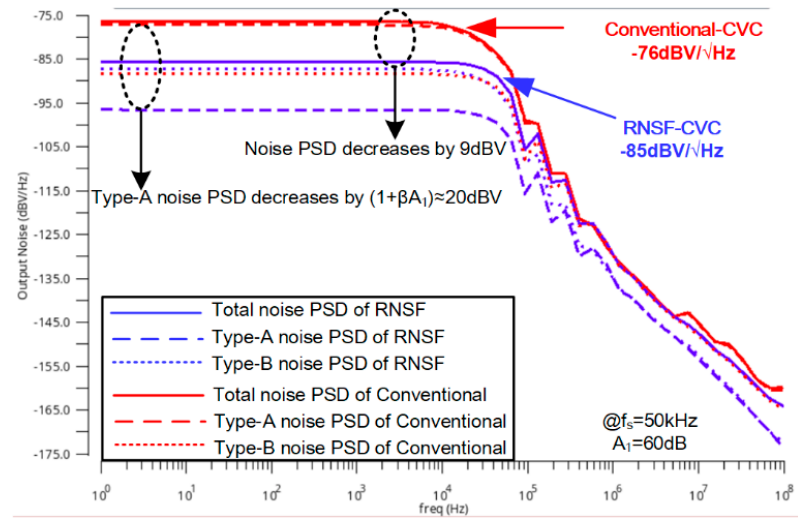
Figure 12. The PSD of RNSF-CVC and conventional CVC.